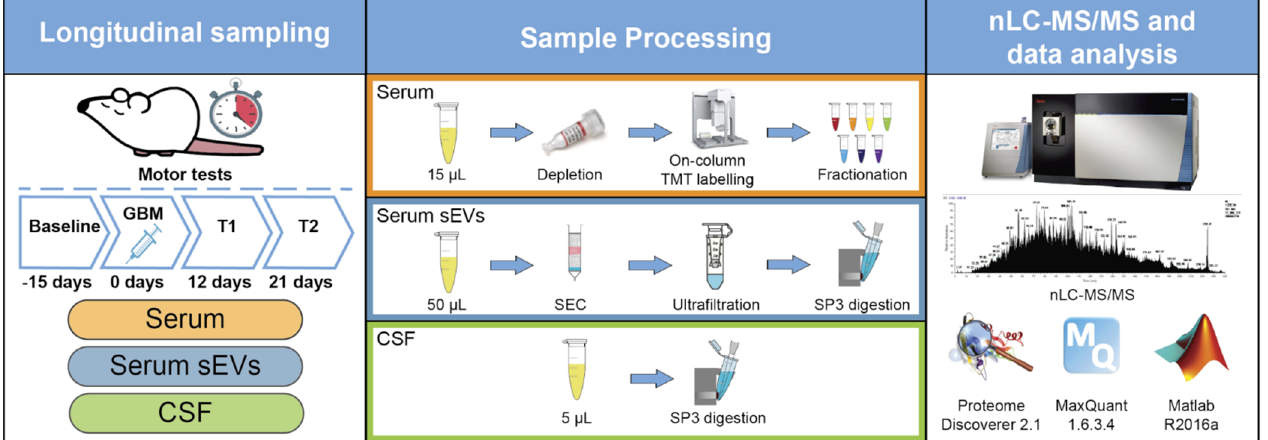
Figure 6. Summary of the experimental workflow. A GBM syngenic murine model was used in the study and tumor progression was monitored by motor tests. Serum, serum sEVs, and CSF samples were collected for baseline, pre-symptomatic (T1), and late-stage (T2) GBM progression. Proteins were extracted, processed, and analyzed by nLC-MS/MS. Proteins were identified using Proteome Discoverer 2.1 and MaxQuant 1.6.3.4. A linear mixed effect model for longitudinal data analysis was implemented in Matlab v.R2016a.